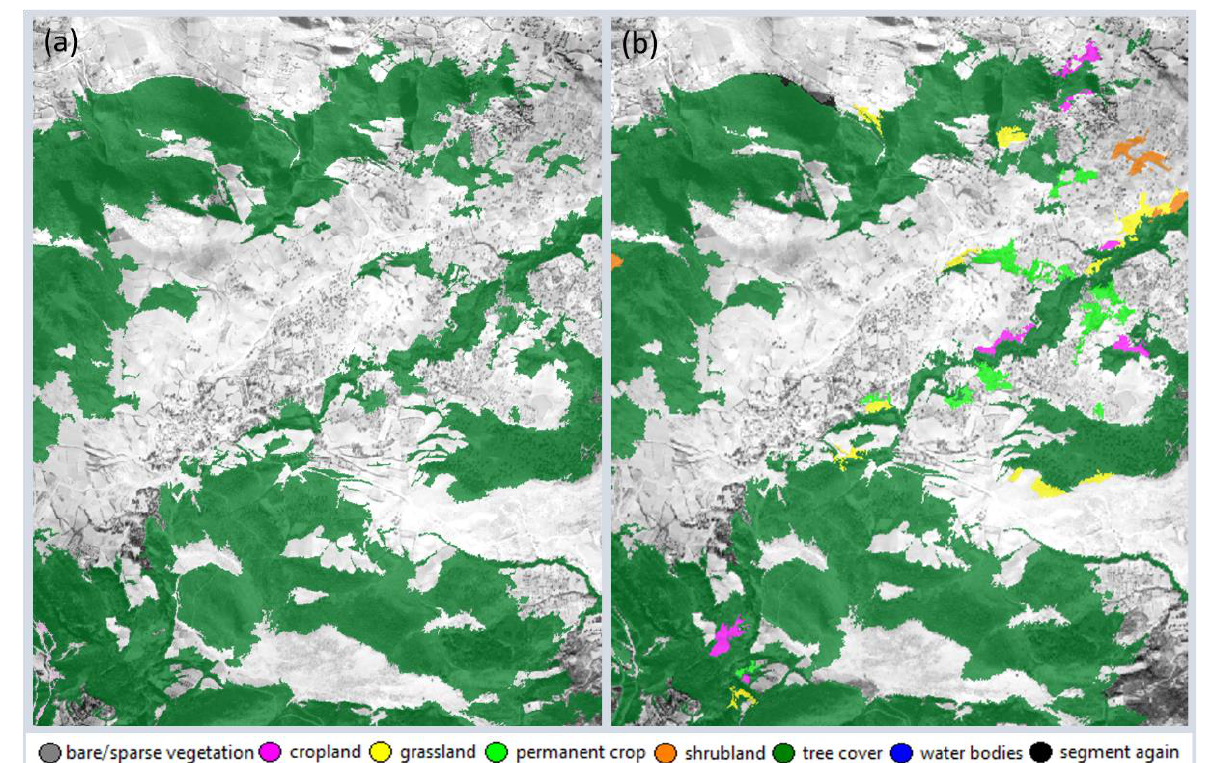
17 of 26 Figure 15. Segmented 1965 Ruen aerial photograph. Segments highlighted by red borders show the objects resulting from small-scale segmentations. At the end of the first phase of image classification, we had the land cover map of the Ruen and Stamboliyski from the 1965 aerial photographs. The additional aerial photo- graphs and satellite images were then segmented and classified using the land cover map of the 1965 aerial photographs. We implemented the segmentation and classification of the images in multiple stages. First, an image was segmented using the scale parameter set to 80, and the shape parameter and the compactness were set as 0.7 and 0.3, respec- tively. The classes given to objects in the 1965 land cover map were then assigned to the segmented objects in stages, one class at a time. We later checked the classified objects manually, and we edited the segments which were misclassified. Misclassified objects can